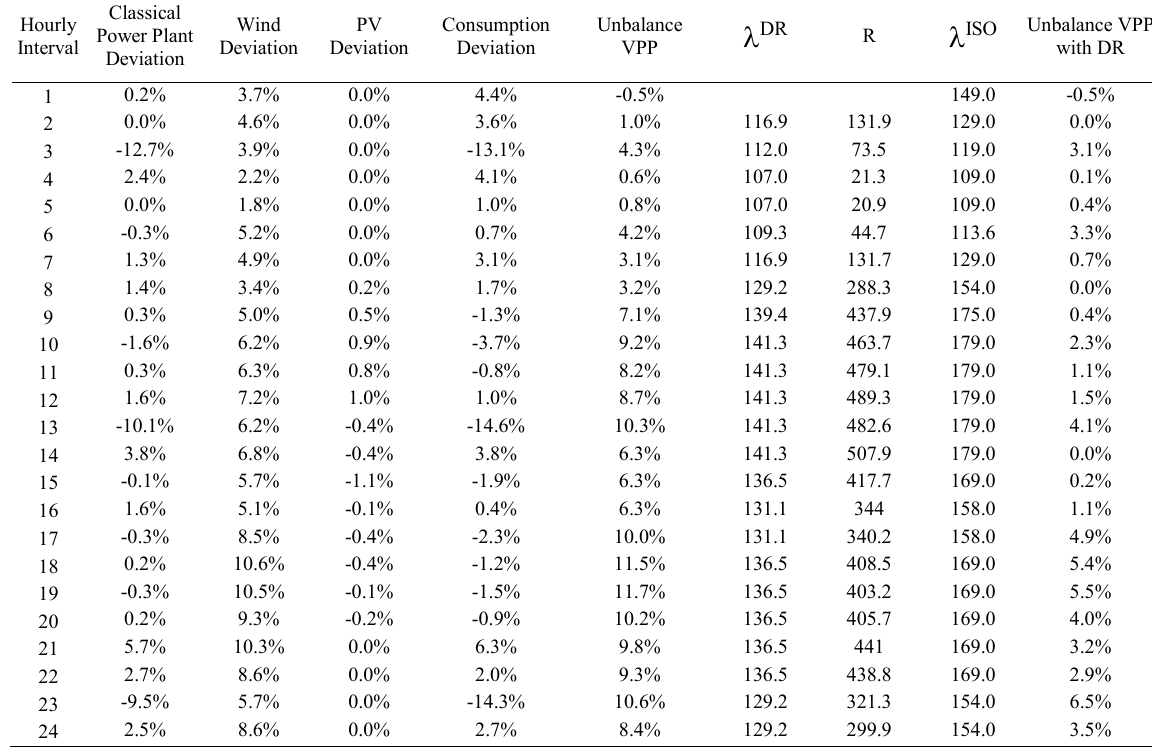
TABLE III VPP U NBALANCE FOR C ASE S TUDY #2 WITHOUT AND WITH